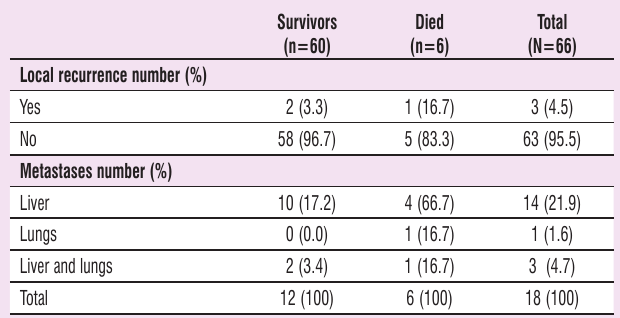
Table 3. Local recurrence and